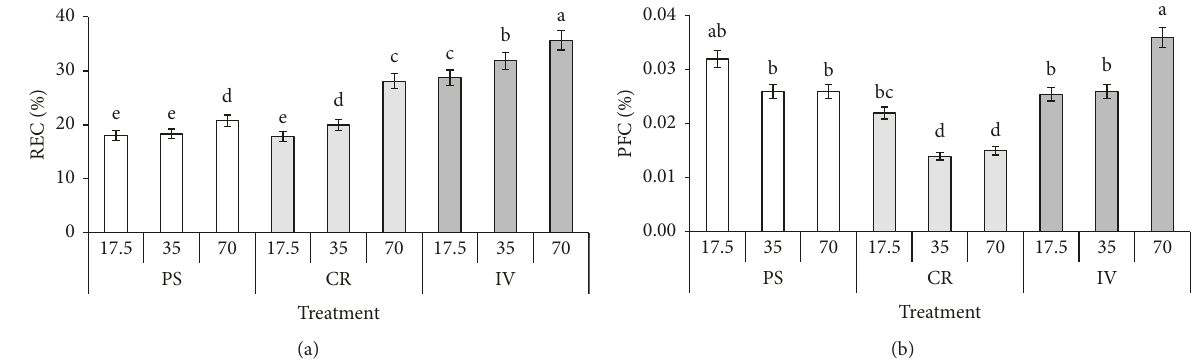
Figure 5: (a) Root ectomycorrhizal colonization (REC) and (b) foliar P content (FPC) of P. maximinoi seedlings as a function of the interaction inoculum type inoculum dose. Bars indicate standard error. Columns with different letters indicate significant difference × ( P 0 . 05) according to the multiple range test of ≤